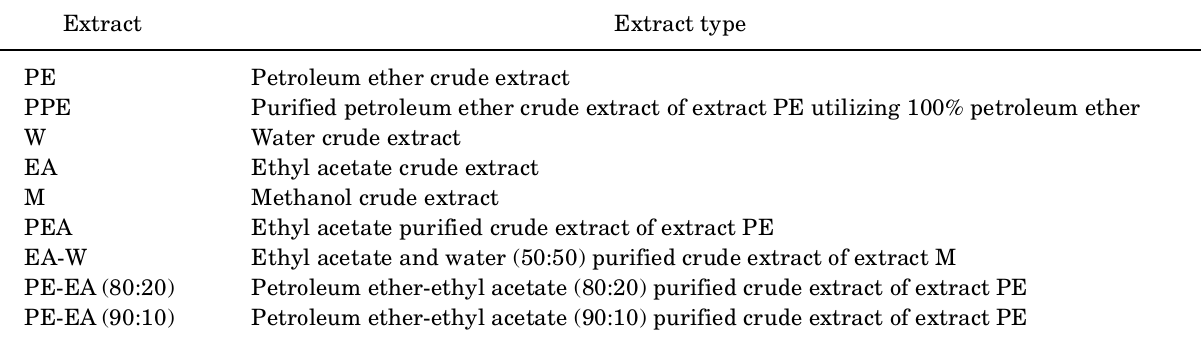
Table 2. Crude extracts from roots of Ferula harmonis tested for the fungitoxic activity against phytopathogenic fungi. Extract Extract type